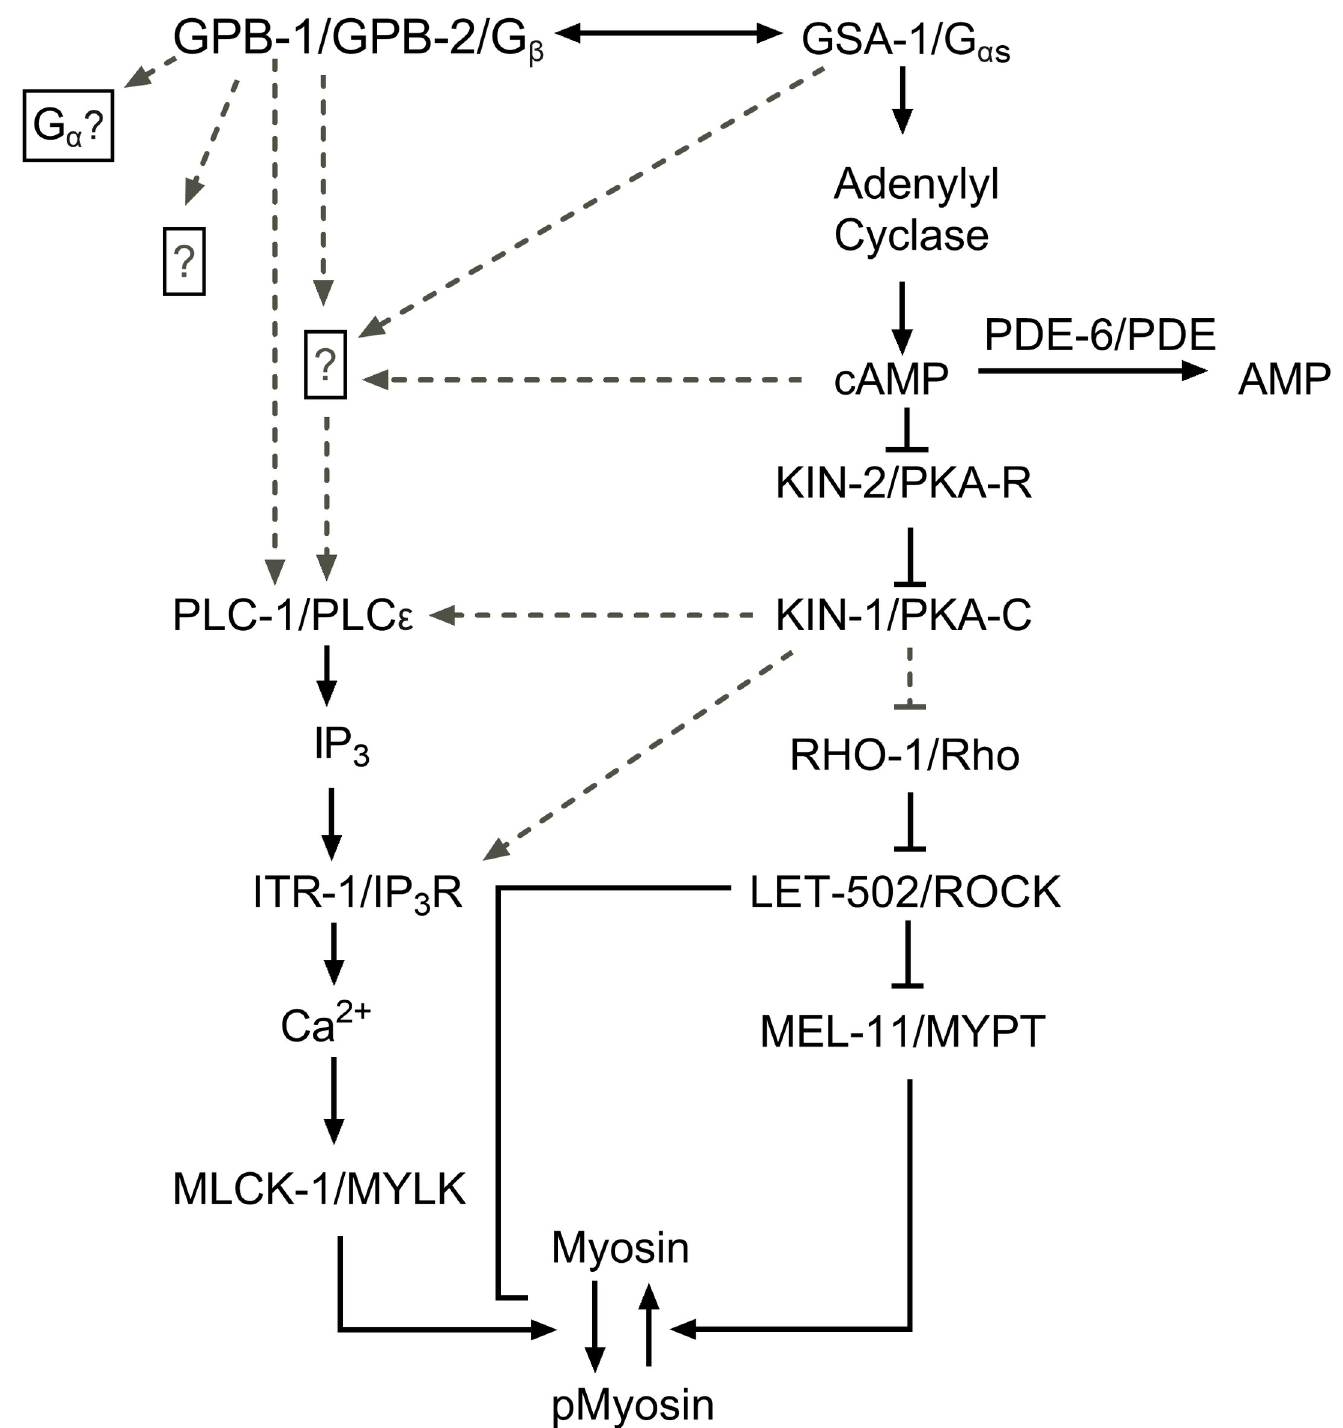
Fig 7. A working model of the spermathecal Ca 2+ signaling network. We propose KIN-1 and KIN-2 are working downstream of GSA-1, while GPB-1 and GPB-2 are either working together with or in parallel to GSA-1 to regulate Ca 2+ signaling and spermathecal contractility. Dashed lines indicate possible interactions.